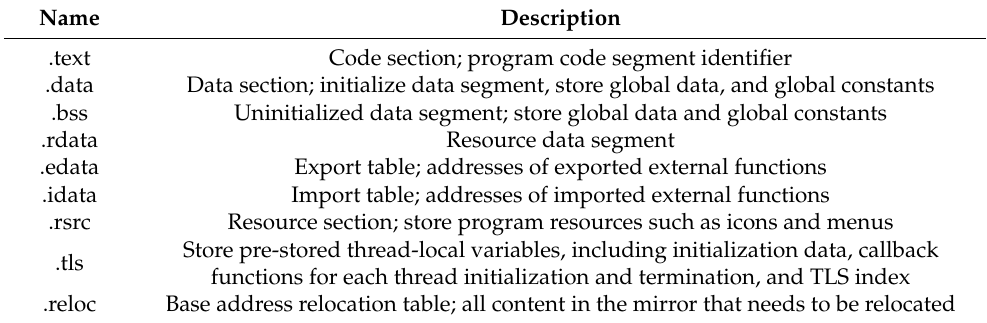
Table 2. List of features in the section category.